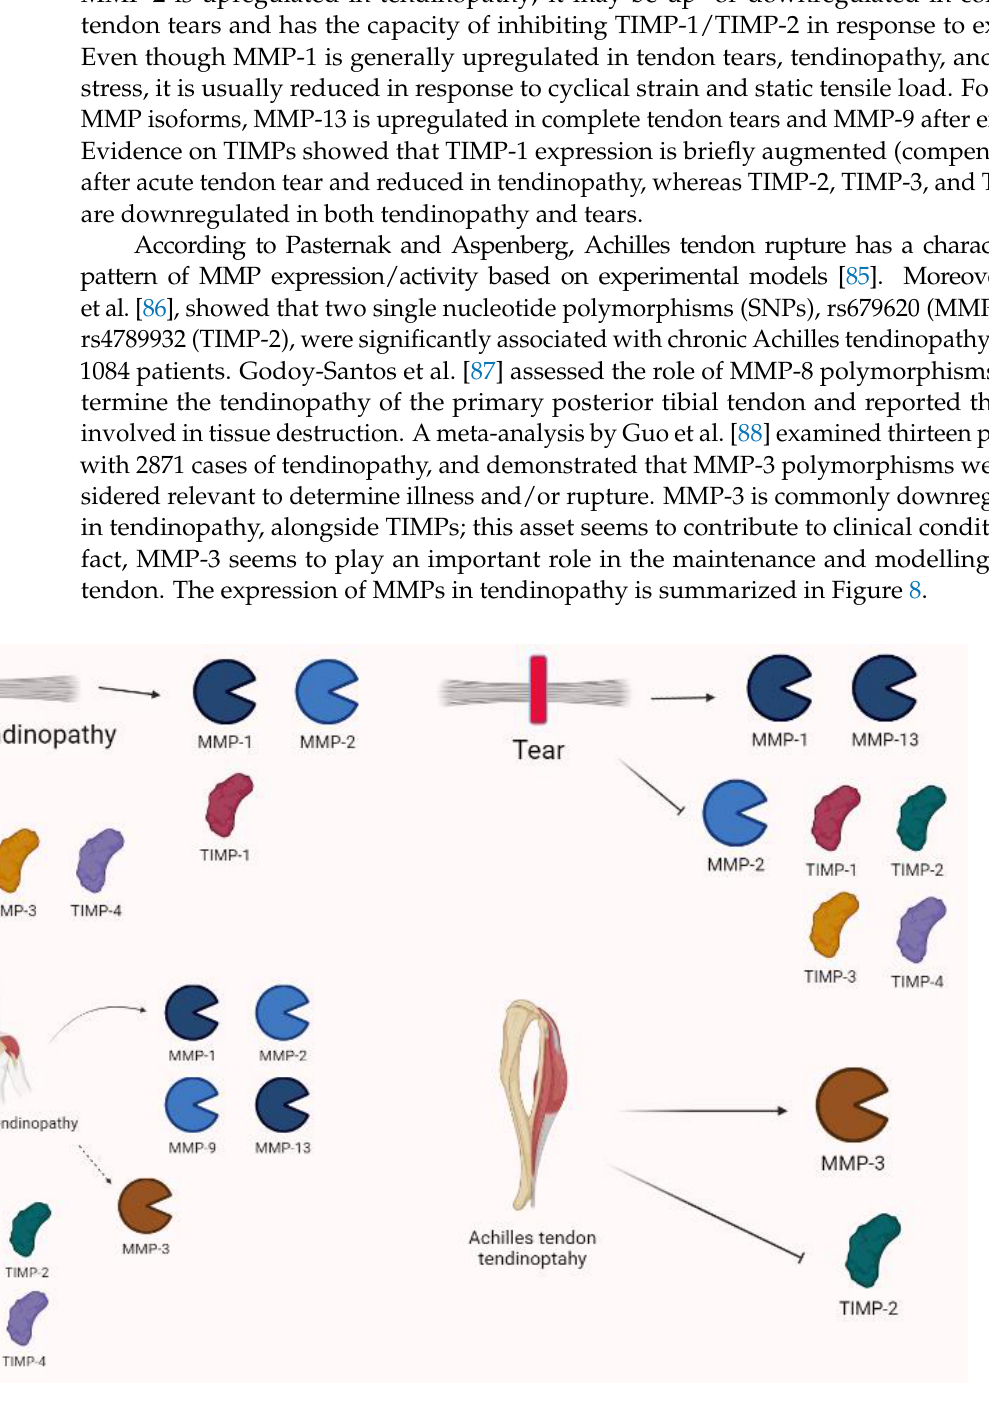
Figure 8. Tendinopathy shows complex and variable expressions of MMPs. In general, MMP-1 and -2 are often increased alongside TIMP-1. Conversely, TIMP-2, -3, and -4 are downregulated. Tears are characterized by increases in MMP-1 and MMP-13, as well as decreases in MMP-2 and TIMP-1, TIMP-2, TIMP-3, and TIMP-4. Specific settings show that rotator cuff tendinopathy variations are characterized by the overexpression of MMP-1, MMP-2, MMP-9, and MMP-13, whereas MMP-3 may be down- or upregulated. TIMP-1 is generally increased, whereas TIMP-2 may be both in- creased or decreased alongside TIMP-3 and -4 in tears. Achilles tendinopathy shows the relevant role of MMP-3 and TIMP-2 in pathogenesis.